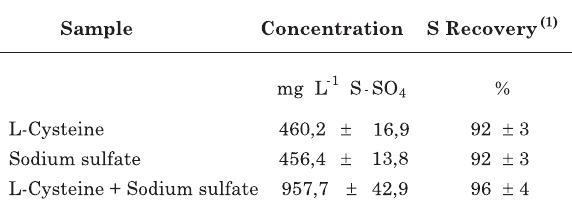
Table 7. Sulfur concentration and alkaline oxidation yield using NaHCO + CuO oxidation mixtures 3